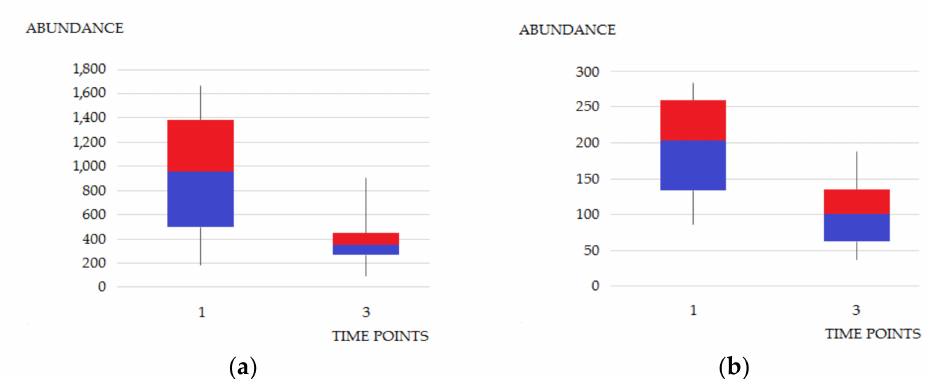
Figure 4. Differences in metabolite abundances at time points “1” (samples collected before TURBT) and “3” (samples collected 14 days after TURBT) for ( a ) 1,3-dimethyluracil and ( b ) N1-methyl-2- pyridone-5-carboxamide. Signal intensities were normalized by SG. p -values, indicating statistical significance of the differences in abundance between time points “1” and “3”, for 1,3-dimethyluracil and N1-methyl-2-pyridone-5-carboxamide were 0.02 and 0.01, respectively. Legend: Line segments, blue and red boxes represent consecutive quartiles. Time points: “1”—samples collected before TURBT; “2”—samples collected the day after TURBT; “3”—samples collected at follow-up visit (14 days after TURBT). The number of samples: “1” = 10, “2” = 10, “3” =